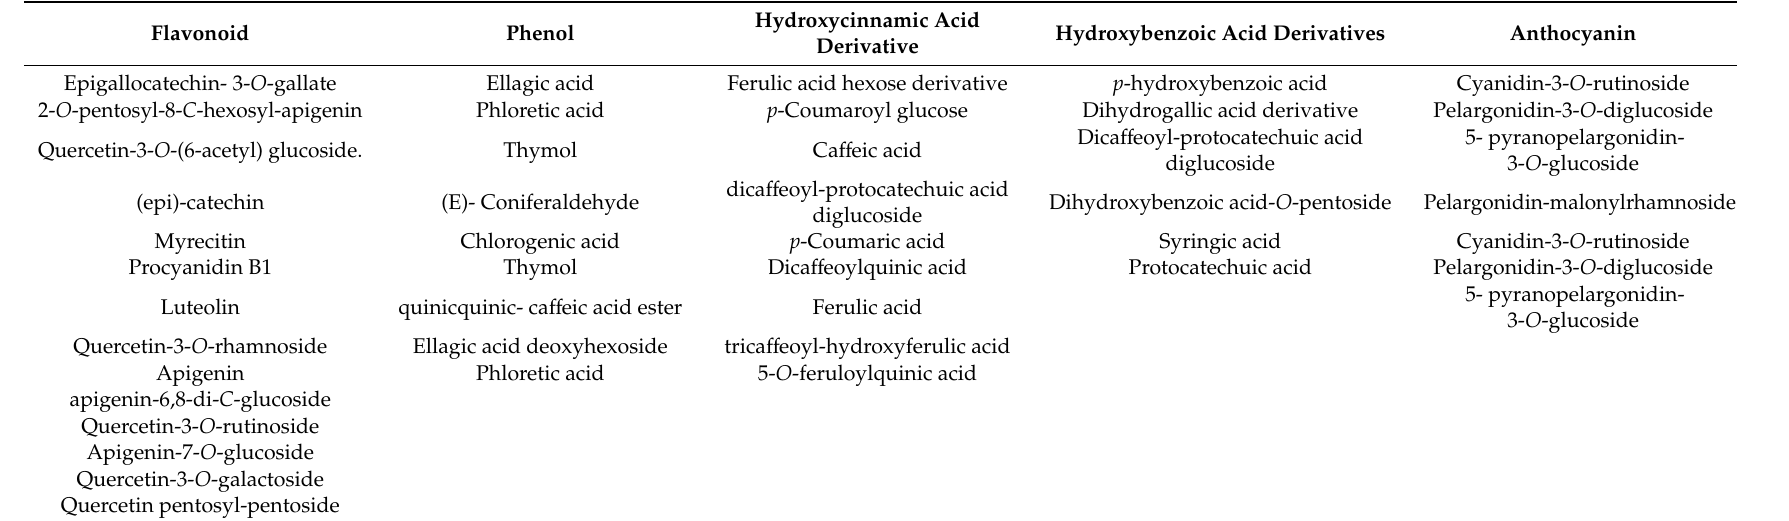
Table 1. Bioactive compounds present in rice